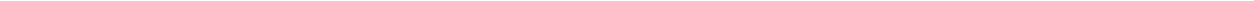
Fig. 4 RNA/hnRNPK-mediated selective interactions between lineage-determining TFs and chromatin modi fi ers. a Western blotting, IP with GATA1 and SPI1/PU.1 antibodies and co-IP with antibodies against various DNA and histone modi fi ers in OCI-M2 and SC cells. b Examination of the effects of 5-AZA on the interactions between SPI1/PU.1 and DNMT1 as well as EZH2 by co-IP in OCI-M2 cells treated with 1 μ M 5-AZA at various time points. c Examination of the effects of 5-AZA on the interaction between SPI1/PU.1 and TET2 by co-IP in SC cells treated with 1 μ M 5-AZA at various time points. d Examination of the RNA-dependence of the interaction between GATA1 and TET2 and the interactions between SPI1/PU.1 and DNMT1 as well as EZH2 by RNase digestion-coupled co-IP in OCI-M2 cells. e Examination of the RNA-dependence of the interaction between SPI1/PU.1 and TET2 by RNase digestion- coupled co-IP in SC cells. f Identi fi cation of hnRNPK as a direct binder of both GATA1 and TET2 by IP with GATA1 antibody and co-IPs with antibodies against various RNA-binding proteins, such as hnRNPA1 and AUF1, in OCI-M2 cells. g A schematic illustration of the nature of the interactions between hnRNPK and GATA1 as well as TET2 in OCI-M2